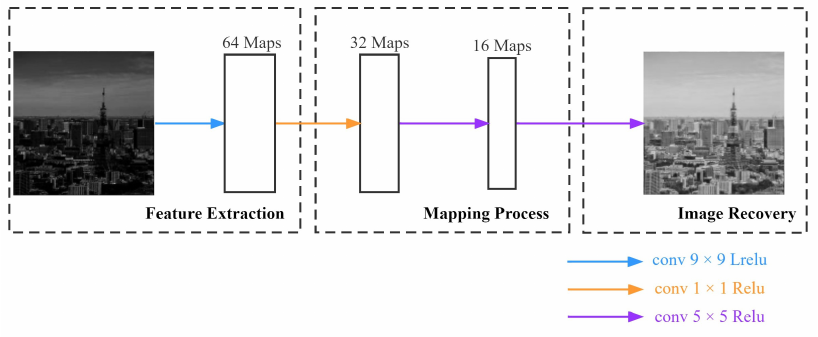
Figure 3. The architecture of CNN